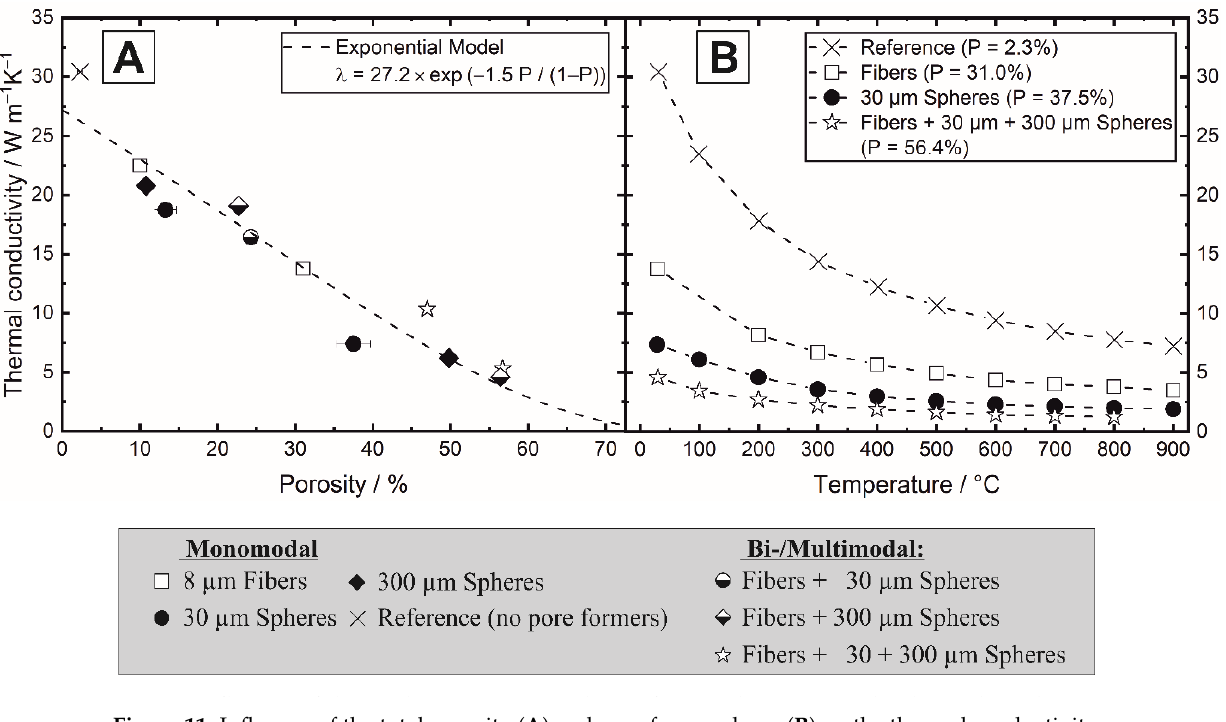
Figure 11. Influence of the total porosity ( A ) and pore former shape ( B ) on the thermal conductivity.